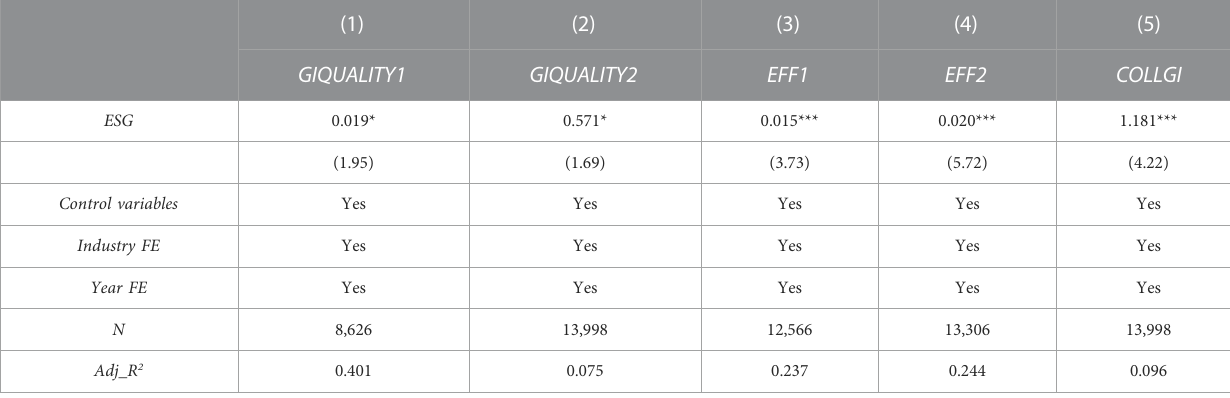
TABLE 10 Further analysis: In fl uence of ESG on corporate collaborative